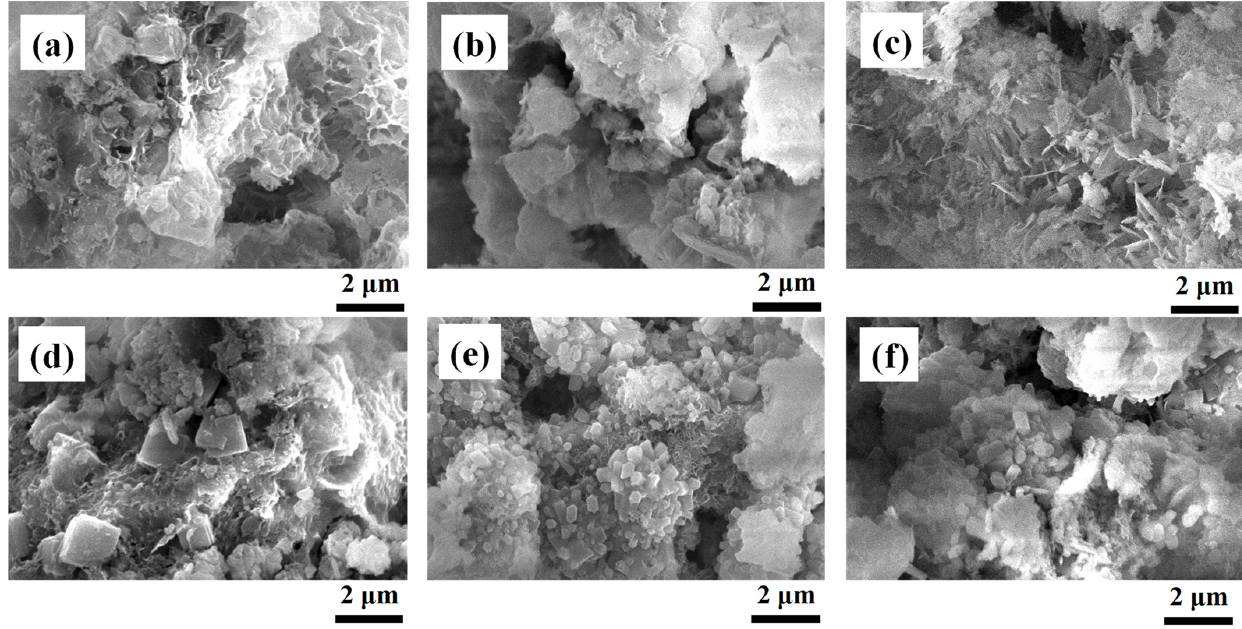
Figure 7. SEM photos of the synthesized products: ( a ) 80 °C without 1 M EDTA, ( b ) 120 °C without 1 M EDTA, ( c ) 160 °C without 1 M EDTA, ( d ) 80 °C with 1 M EDTA, ( e ) 120 °C with 1 M EDTA, and ( f ) 160 °C with 1 M EDTA (NaOH concentration: 3 M NaOH, Reaction time: 24 h).